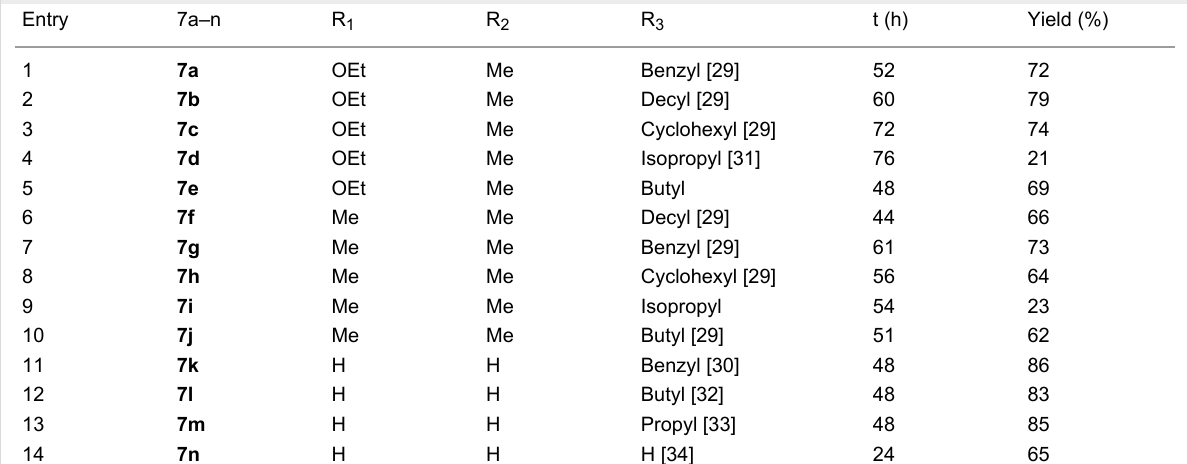
Table 1: Substituted pyrroles ( 7a – n ) prepared by this